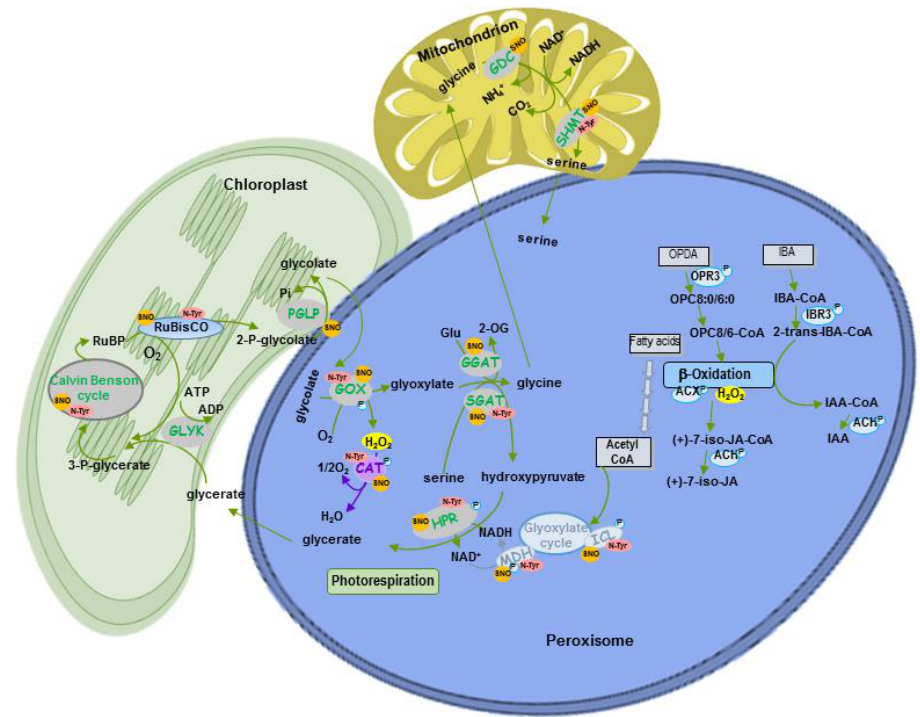
Figure 1. Representative scheme of the main peroxisomal metabolic pathways and their regulation by NO-dependent protein post-translational modifications (PTMs) and phosphorylation. Ph, phosphorylation; SNO, S -nitrosylation; N-Tyr, nitration.